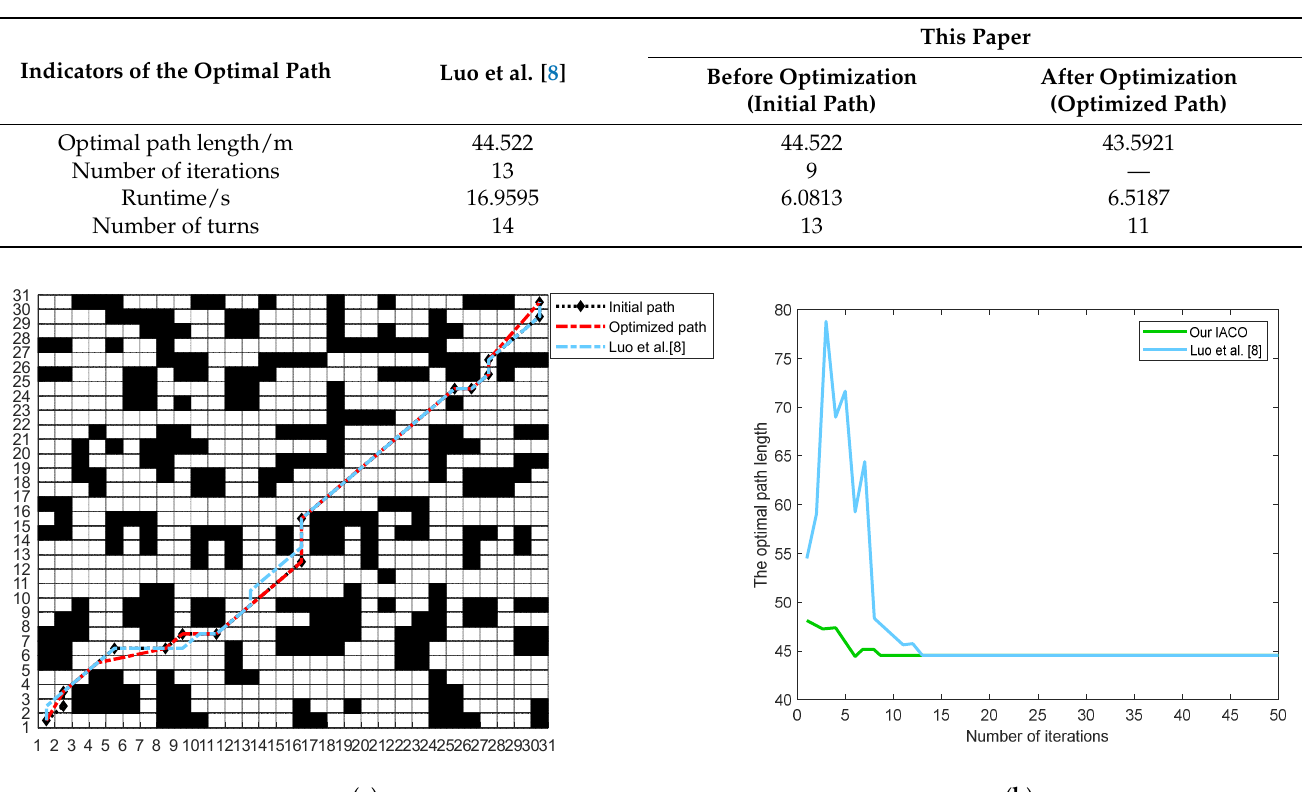
Table 5. Comparison of the results of the two algorithms in global path planning.